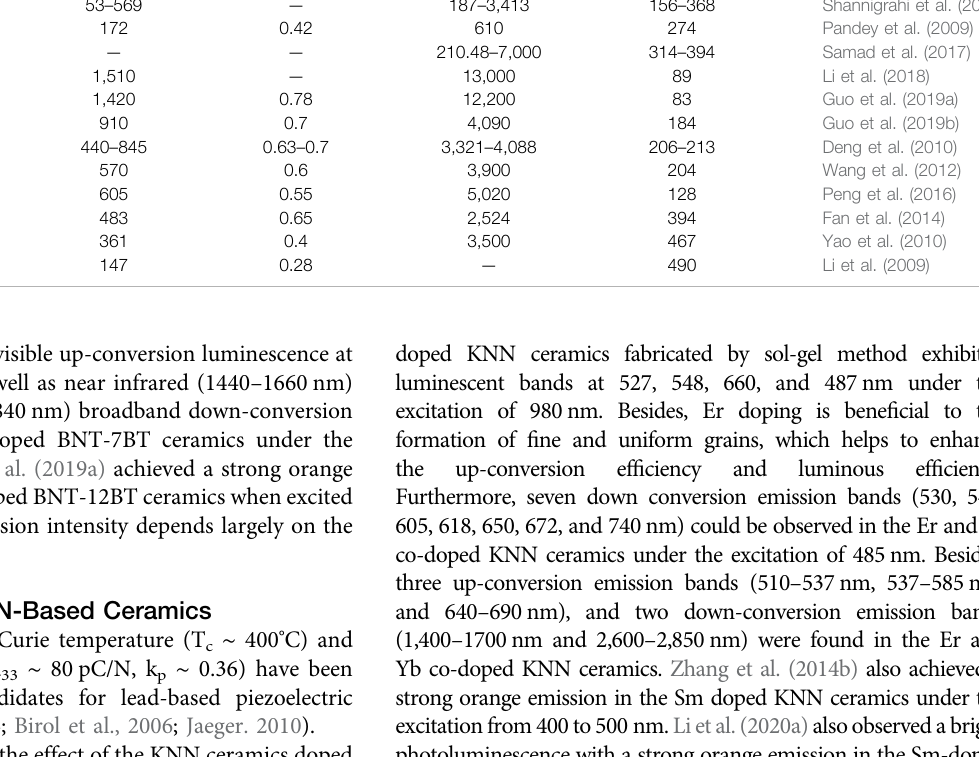
TABLE 1 | The properties of some lead-based piezoelectric ceramics with rare-earth doping.